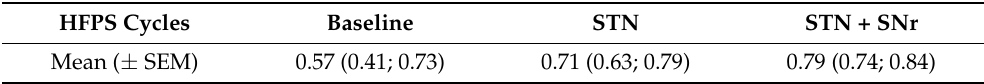
Table 1. Summary of gait analysis data HFPS: heel strike, foot contact, push off and swing; STN: Subthalamic nucleus stimulation; STN + SNR: Dual Subthalamic and nigral stimulation; SEM: Standard error of the